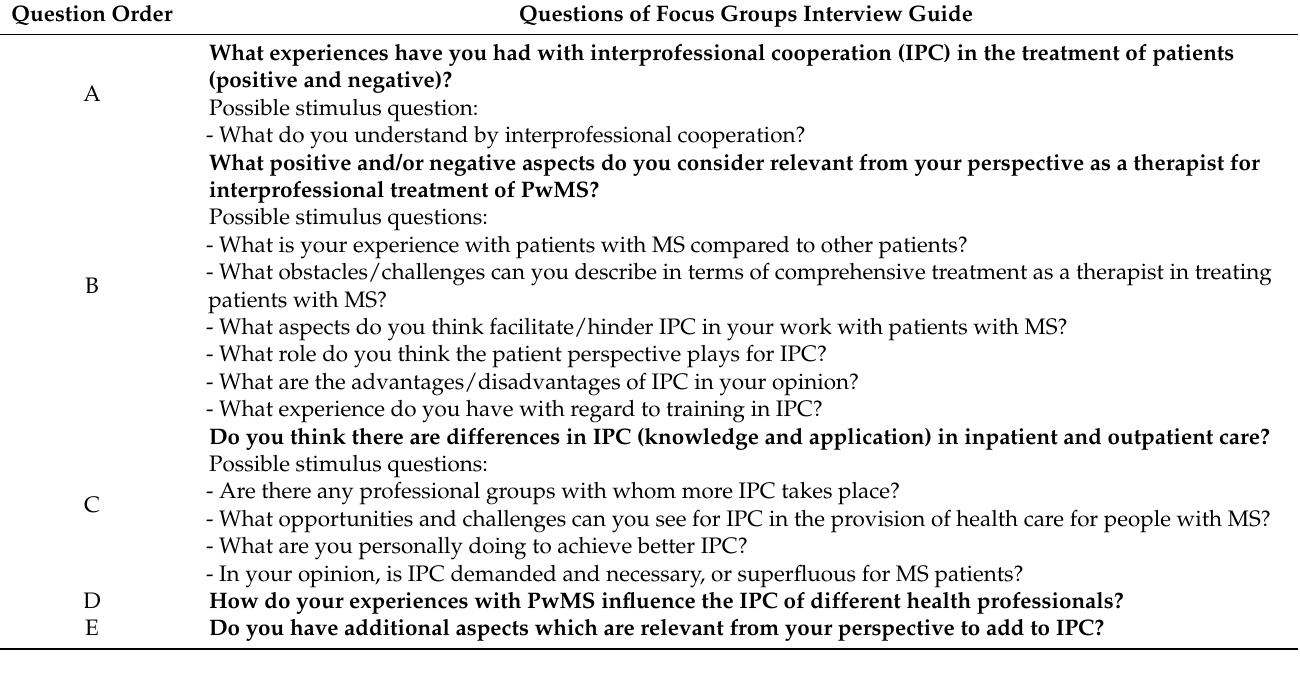
Table 1. Questions of focus group interview